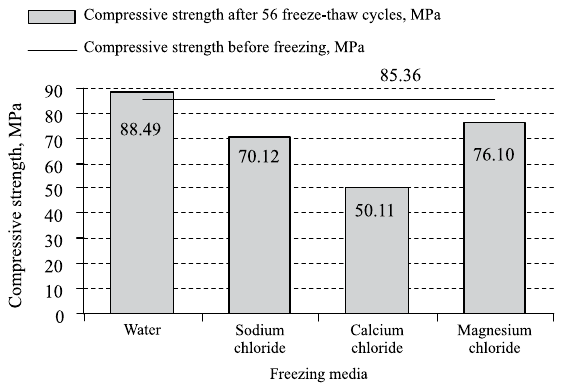
Fig. 1. The dependence of compressive strength on saline solution type in specimens made of Portland cement without additives